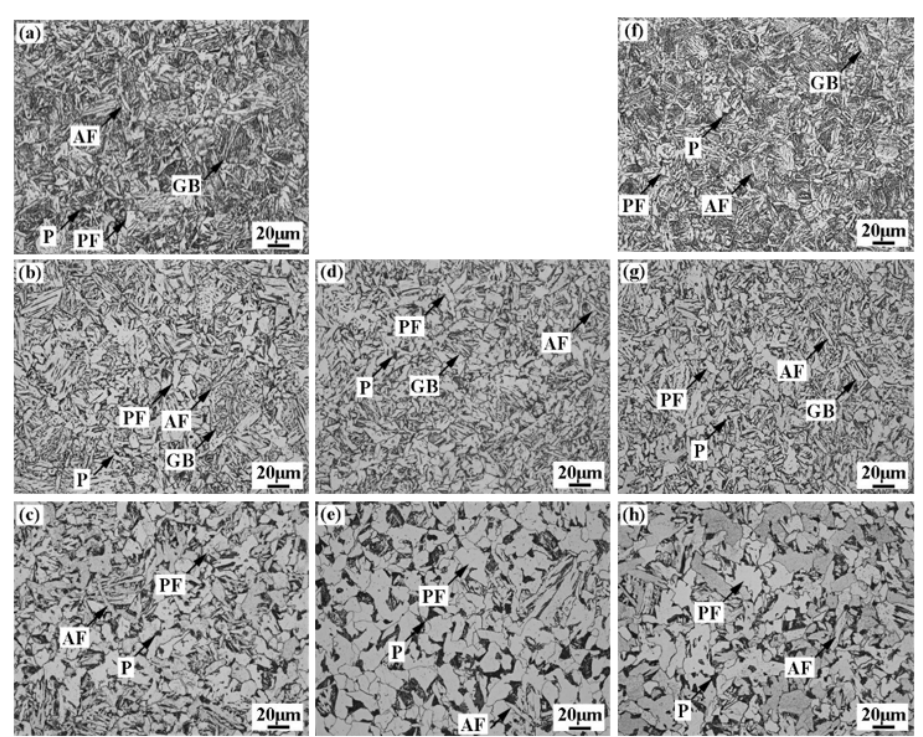
Figure 4. Steel-plate microstructure at the different temperature measurement points. Images ( a – h ) demonstrate the microstructure at points P1–P8, respectively. Metals 2020 , 10 , x FOR PEER REVIEW